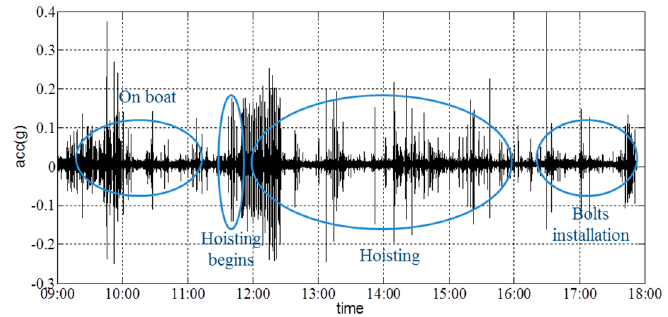
Figure 25. Vertical-acceleration time-history curve.